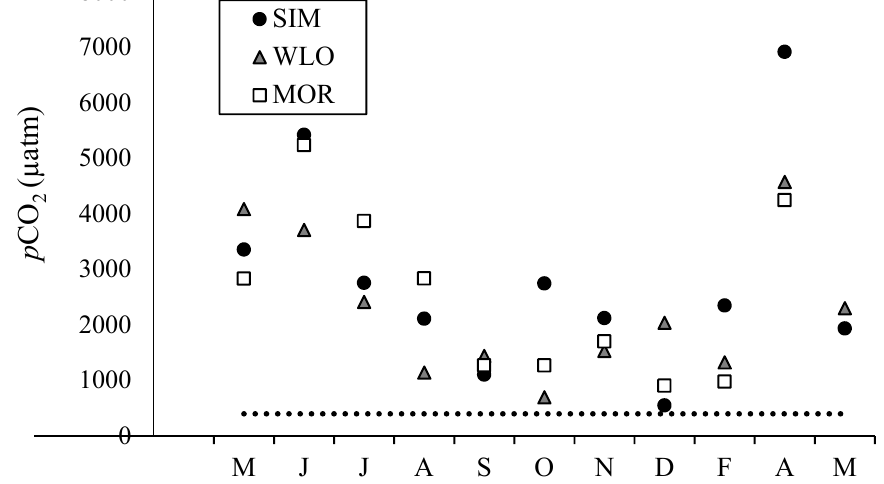
Figure 4. p CO 2 at the upstream (Simmesport) and downstream locations (Wax Lake Outlet and Morgan City, WLO and MOR) of the Atchafalaya River from May 2015 to May 2016 (no measurements from the 31 January 2016 and 27 March 2016 sampling events because of equipment malfunction). The dotted line represents atmospheric equilibrium.